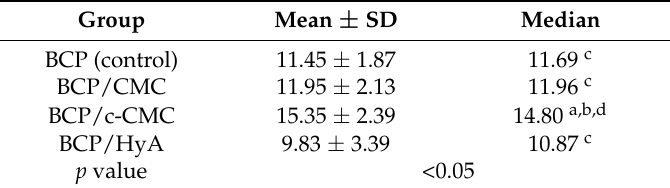
Table 2. New bone volumes within regions of interest ( n = 7; mm 3 ).